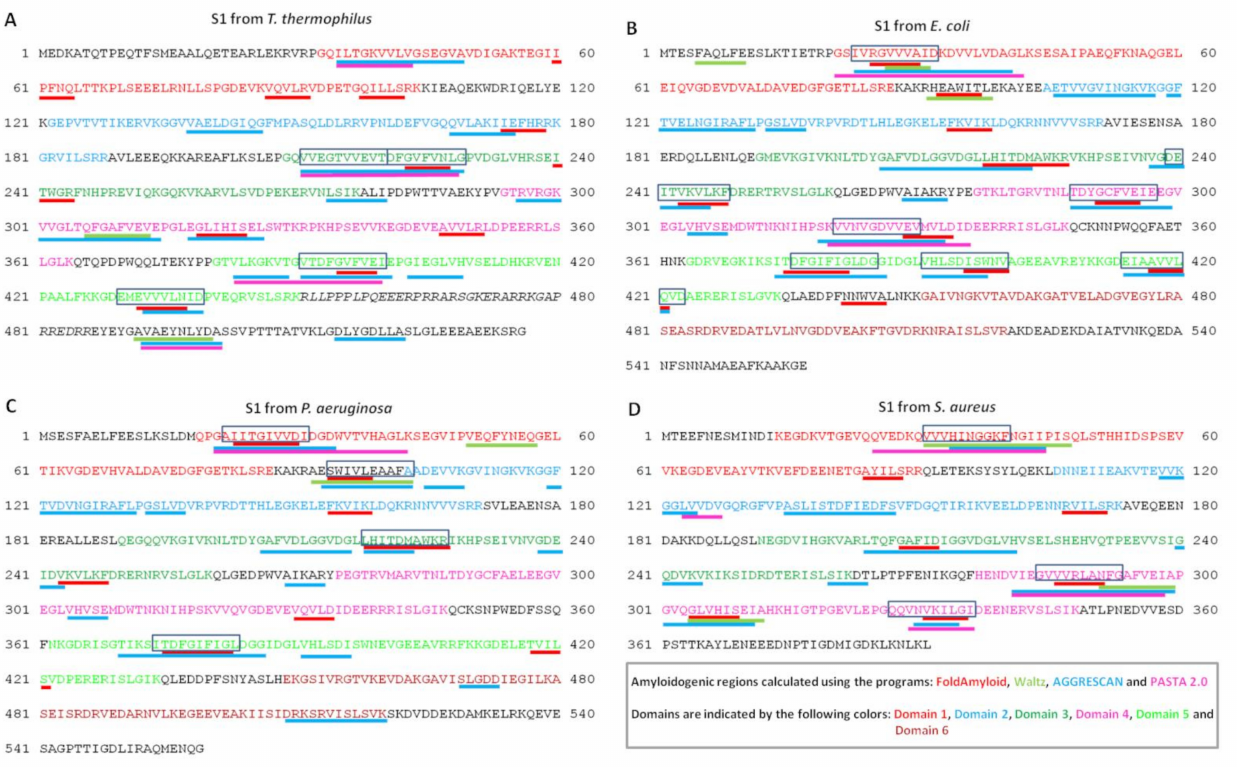
Figure 7. Predicted amyloidogenic regions for ribosomal S1 protein from four organisms T. thermophilus ( A ), E. coli ( B ), P. aeruginosa ( C ), S. aureus ( D ) using four programs: FoldAmyloid, Waltz, AGGRESCAN, and PASTA 2.0. The synthesized peptides are circled in a